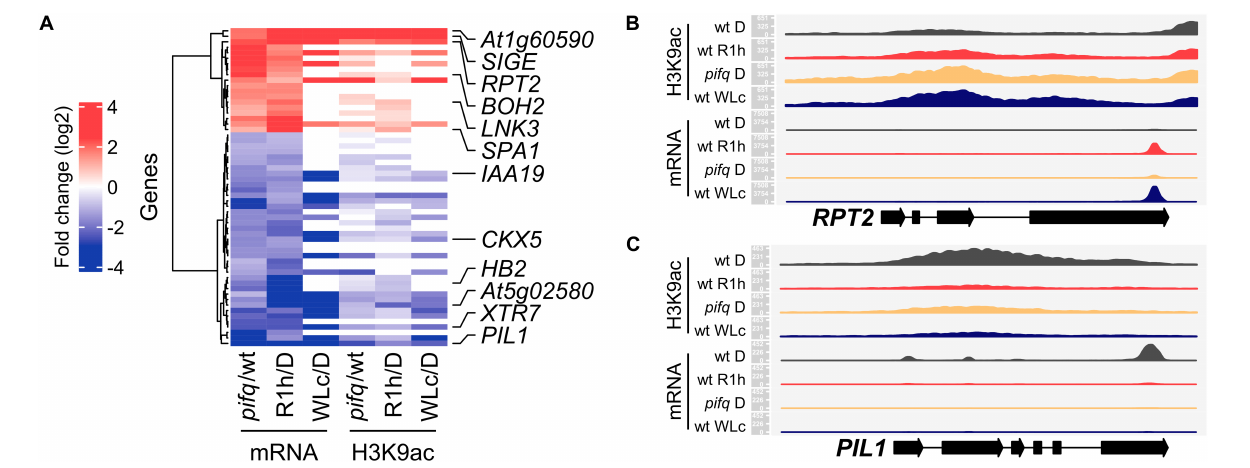
FIGURE 3 | H3K9ac levels change in light-responsive PIF-DTGs (LRP-DTGs) both in pifq and in response to red light. (A) Heat-map showing the changes in mRNA and H3K9ac levels comparing dark-grown pifq versus wild type, red-light treated (R1h) versus dark-grown wild type (D), and continuous white light-grown (WLc) vs. dark grown wild-type seedlings. All the PIF-DTGs that showed statistically significant two-fold change in mRNA levels in the same direction in pifq vs. wt and R1h vs. D are shown. Six light-induced/PIF-repressed and six light-repressed/PIF-induced genes for further analyses are highlighted. (B) Read mapping profile of H3K9ac ChIP-seq and RNA-seq in RPT2, a light-induced LRP-DTG. (C) Read mapping profile of H3K9ac ChIP-seq and RNA-seq in PIL1, a light-repressed LRP-DTG. For each gene, 1000 bp upstream and 250 bp downstream of their representative transcript are shown. Read count is scaled independently for each gene, and for mRNA and H3K9ac levels. RNA-seq data from pifq seedlings and their corresponding wild-type control were obtained from Zhang et al. (2013). Note that RNA-seq was performed on 3 (cid:48) -end purified